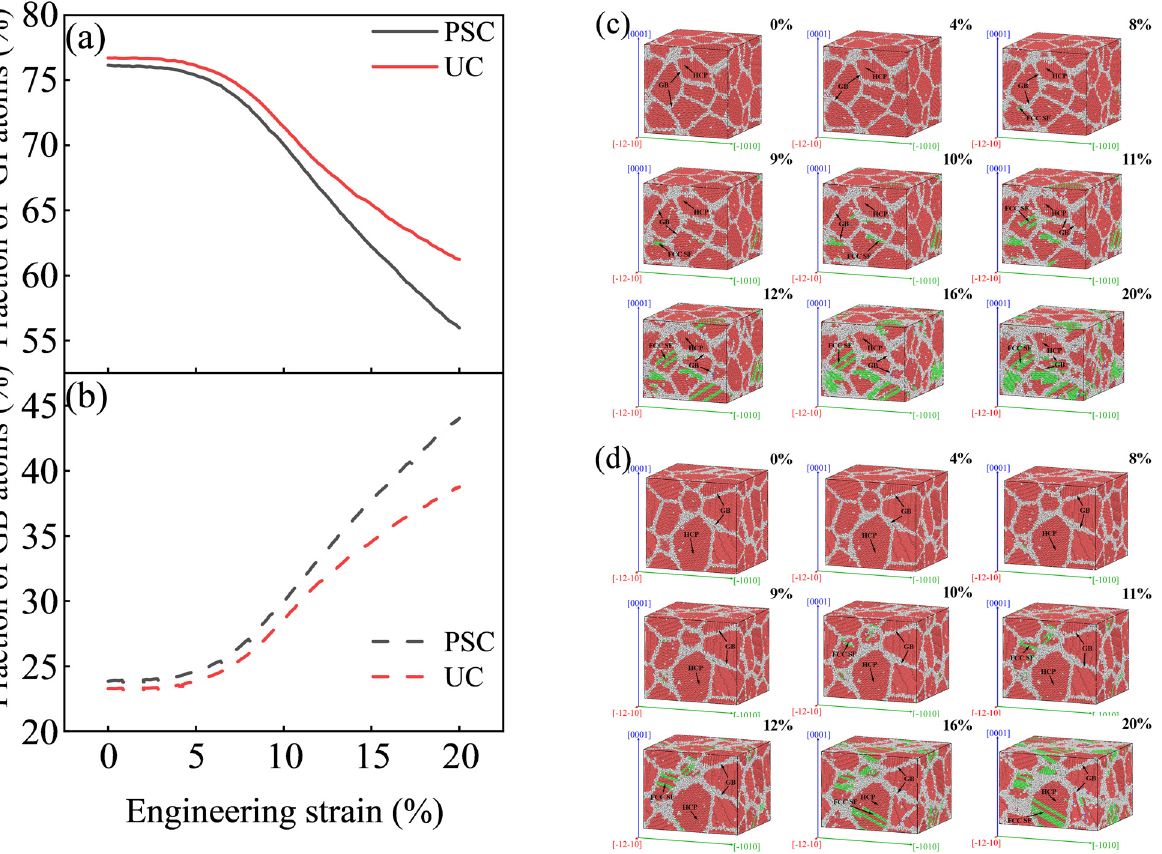
Figure 6: Grain boundary evolution: ( a ) fraction curve of GI atoms, ( b ) fraction curve of GB atoms ( c ) fi gure of CNA under PSC and ( d ) fi gure of CNA in